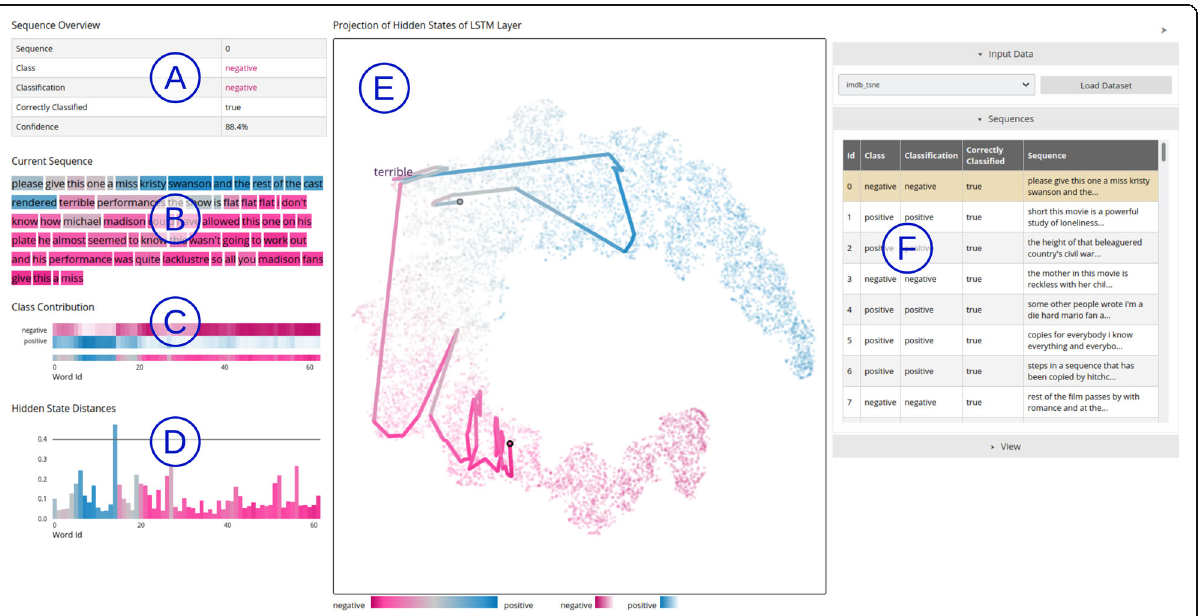
Fig. 2 Detailed view for one selected sequence from the IMDB dataset. Different information and interactive visualizations are shown on panels (A) to (D). (A): The sequence ID and information about the classification; (B): The input sequence with each word colored according to its expected prediction (EP), i.e., what output the model would produce if that word was the last in the sequence; (C): A heatmap matrix displaying how the model ’ s prediction evolves during the sequence processing for each class (top) and overall (bottom); (D): A histogram of the Euclidean distances between the hidden states of the input sequence; (E): The center highlights in the projection the hidden states produced by the sequence, giving insight into how the hidden state evolves over the sequence processing. It is possible to define a threshold for distances to show words in the projection resulting from a larger change in the hidden state; this threshold is also visible as a horizontal line in the histogram; (F): On the right side, the currently selected sequence is highlighted in a list. In the example used for these visualizations, we note how the model first believed the sequence to be classified as positive during the first few time steps of the input sequence. However, as it obtained more information about the input, it changed its output to a negative value. Underlying data source: IMDB as available in Keras